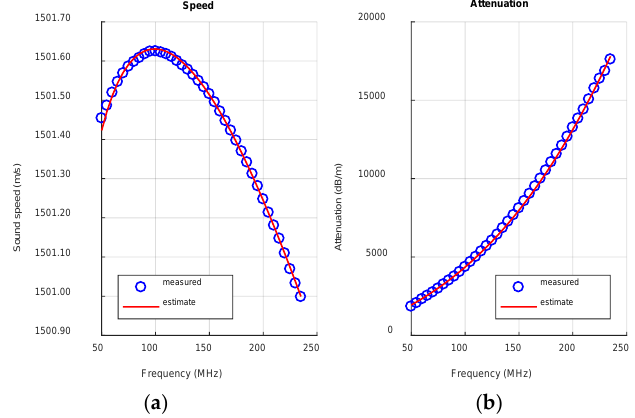
Figure 3. ( a ) Measured and estimated fit of the speed of sound and ( b ) attenuation for a dispersion containing standardized silica particles with a mean diameter around 794 nm and a weight concentration of 5 w %.